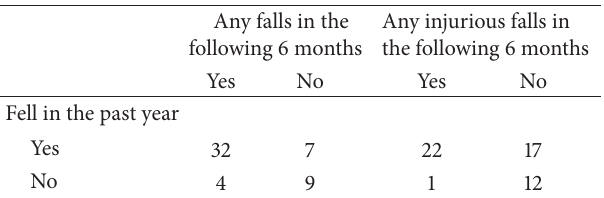
Table 4: Association between falls in the past year and falls or inju- rious falls in the following 6 months. Any falls in